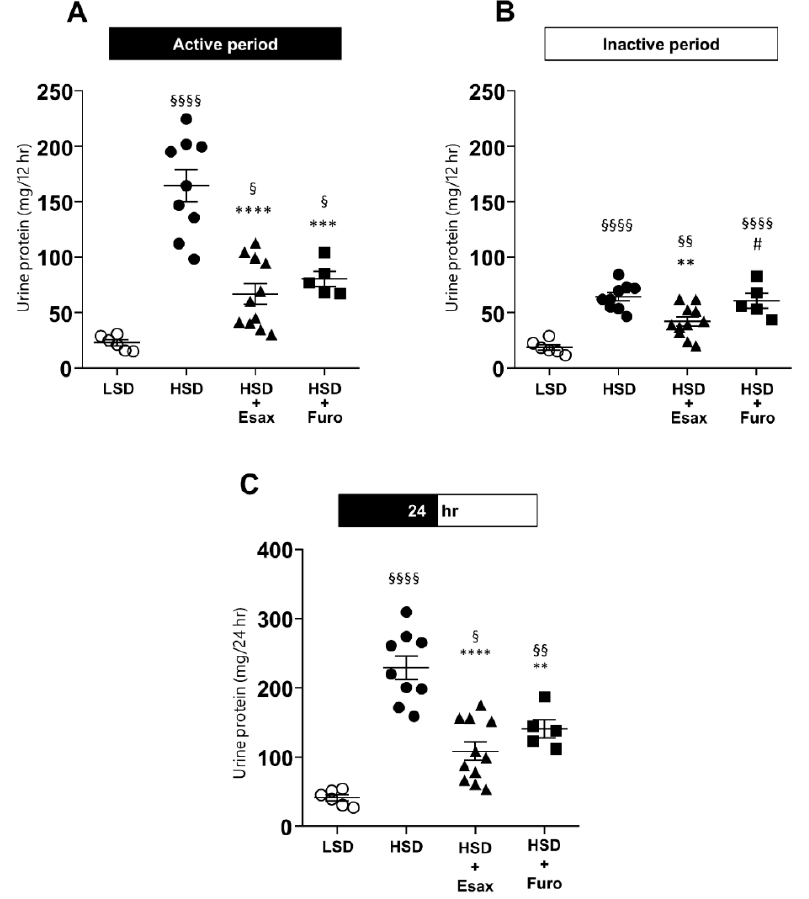
Figure 6. Urinary protein excretion. Mean 12 h urinary protein excretion in the ( A ) active and ( B ) inactive periods, and ( C ) at 24 h. § p < 0.05, §§ p < 0.01, §§§§ p < 0.0001 vs. LSD; ** p < 0.01, *** p < 0.001, **** p < 0.000 1 vs. HSD; # p < 0.05 vs. HSD plus esaxerenone.